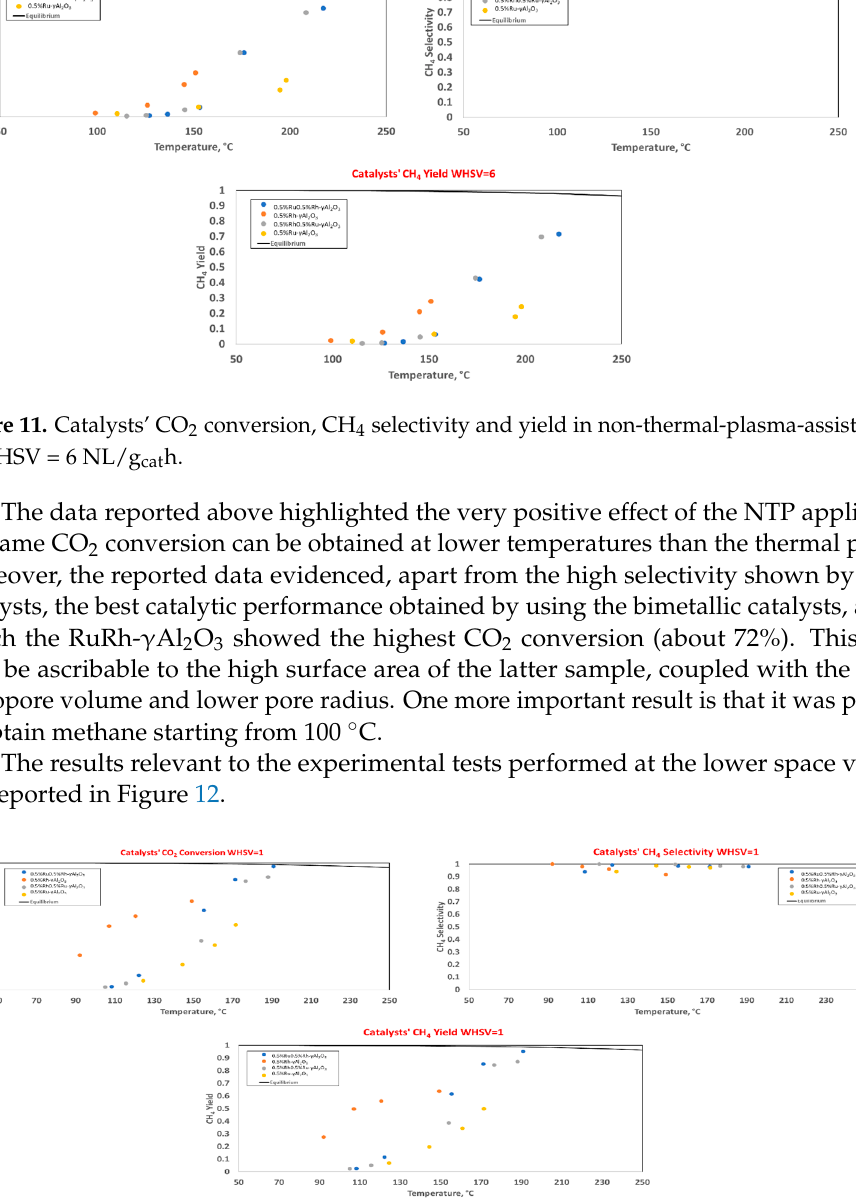
Figure 10. RuRh- γ Al 2 O 3 CH 4 selectivity comparison between the two space velocities.